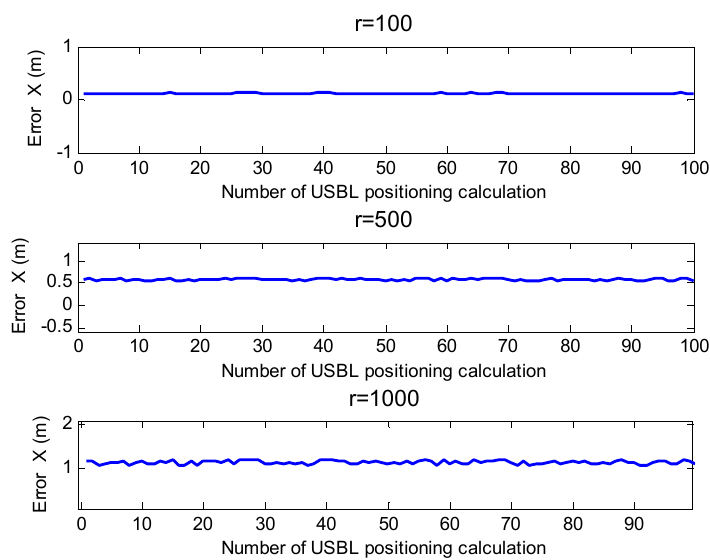
Figure 16. Horizontal positioning error at different positioning distances (based on the rotating array and reusing elements method).